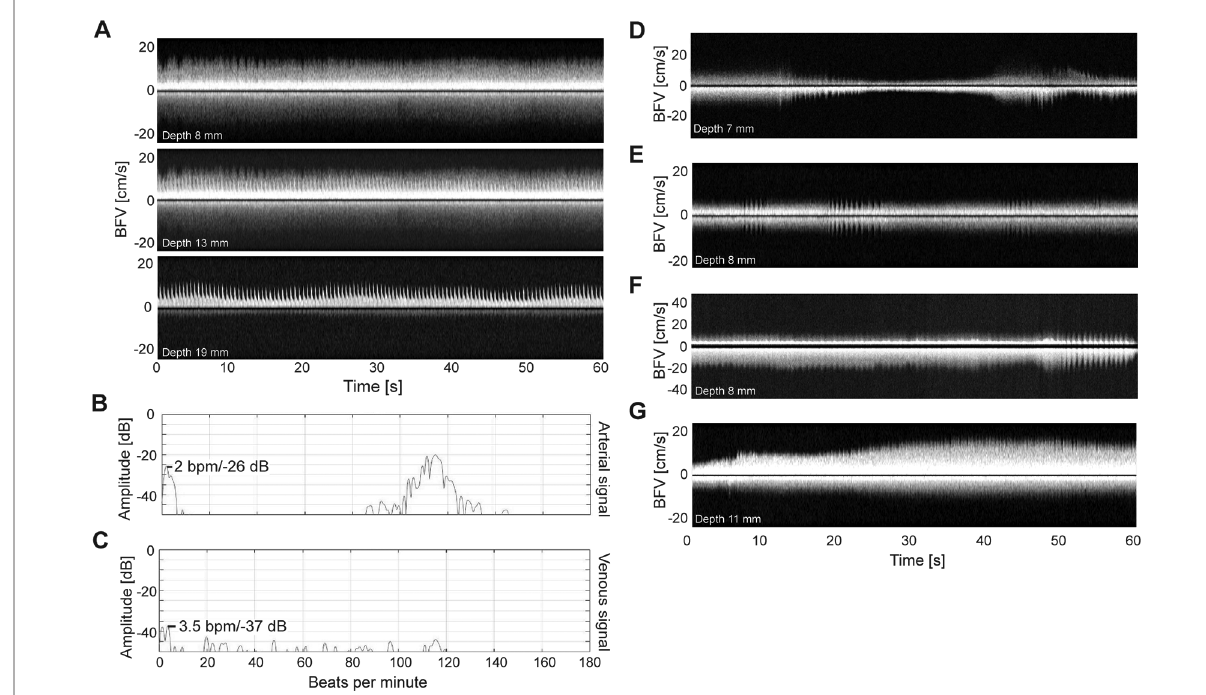
FIGURE 3 Examples of venous signals and the relationship between arterial and venous signals. ( A ) the Doppler velocity curves from a vein at 8 mm depth (upper panel), an artery at 19 mm depth (lower panel), and their relation to each other at 13 mm depth (middle panel). ( B,C ) the frequency spectrums of the vein (8 mm) and artery (19 mm) with beats/min along the x -axis and amplitude (decibel) along the y -axis. ( D – G ) Five typical examples of venous velocity measures. Each recording is from different neonatal subjects. Example 3 D,E is recorded during sleep and 3 F,G is recorded during wakefulness. The x -axis represents time of recording (seconds) and the y -axis represents velocity